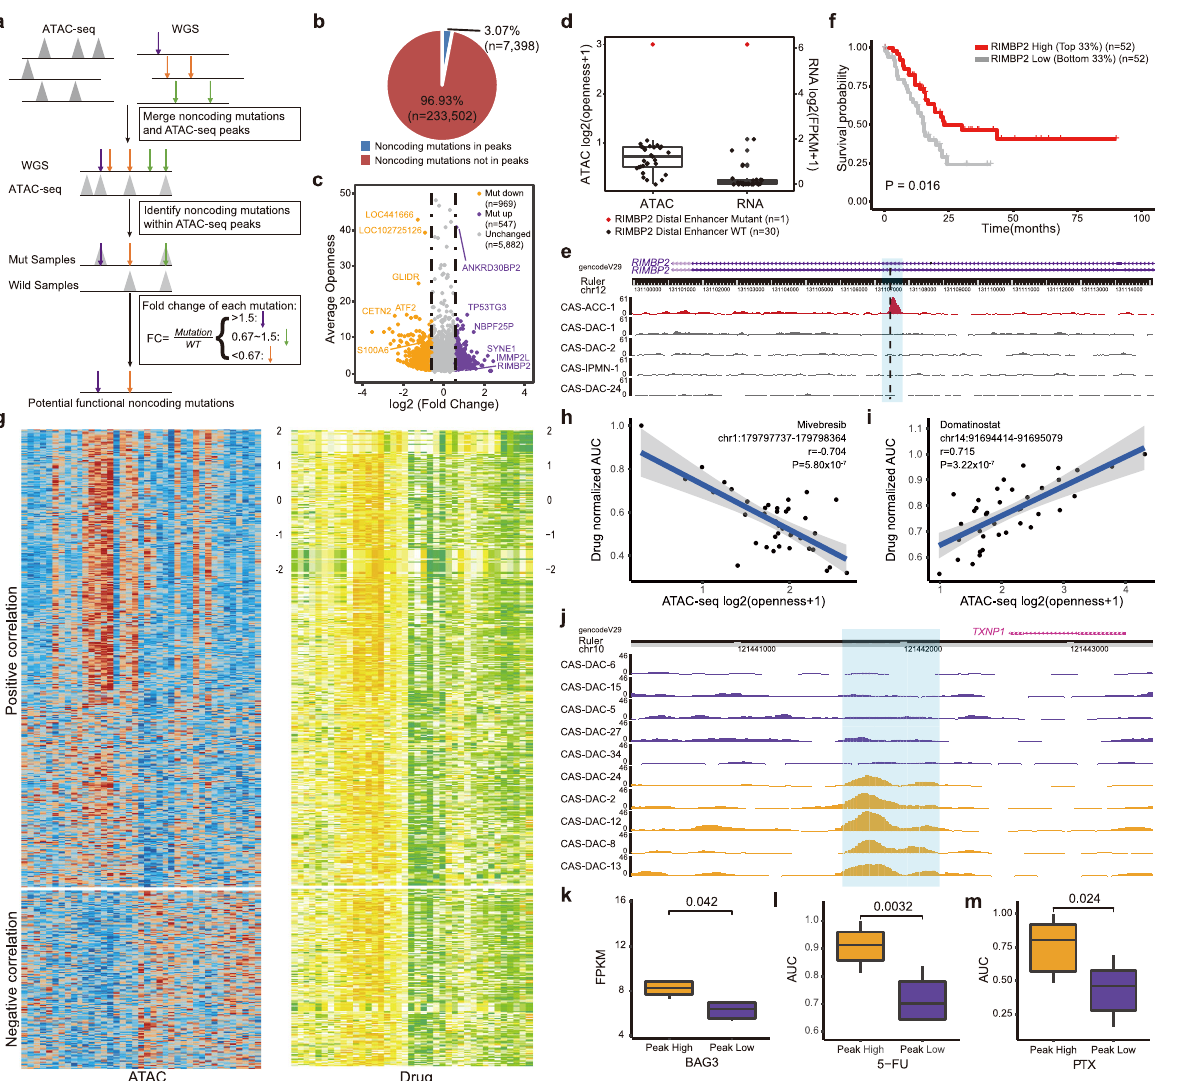
Fig. 5 Integrated analysis of noncoding mutations and drug sensitivity in PDPCOs. a Schematic for identifying potential functional noncoding mutations in 31 exocrine PDPCOs. b Proportions of noncoding mutations located within and outside ATAC peaks. c Dot plot showing fold change in accessibility at ATAC-seq peaks containing noncoding mutations across above 31 exocrine PDPCO. d Box plot showing chromatin accessibility at RIMBP2 putative enhancer and RIMBP2 gene expression across above 31 exocrine PDPCOs. Boxplot show the median (central line), the 25 – 75% interquartile range (box limits). e Normalized ATAC-seq tracks of RIMBP2 putative enhancer locus in 5 representative samples. The red and gray tracks represent samples with and without mutation of the RIMBP2 putative enhancer, respectively. Black dotted line indicates the position of the mutation, and the predicted enhancer region is highlighted by light blue shading. f Kaplan-Meier analysis of overall survival in the TCGA PAAD cohort strati fi ed by high and low expression of RIMBP2 gene. P value is determined by using log-rank test. g Heatmap of 15,397 putative peak-to-drug links in 39 exocrine PDPCOs. Each row represents an individual link between one ATAC-seq peak and one drug. The color represents the z-score for chromatin accessibility (left) or the z-score for drug AUC (right). Dot plot showing a representative negative correlation in h and a representative positive correlation in i . Signi fi cance is computed by Pearson ’ s correlation coef fi cients without adjustment. j Normalized ATAC-seq tracks of BAG3 putative enhancer locus in 10 representative samples. The yellow and purple tracks represent samples with and without peaks in BAG3 putative enhancer, respectively. The peak region is highlighted by light blue shading. Comparison between peak high group with peaks in the BAG3 putative enhancer and peak low group without such peaks in the above 10 samples of BAG3 gene expression in k , AUC of 5-FU in l and AUC of PTX in m . Each group contains 5 biologically independent samples. Boxplot show the median (central line), the 25 – 75% interquartile range (box limits). Signi fi cance is computed by two-sided unpaired t test. PDPCO, patient-derived pancreatic